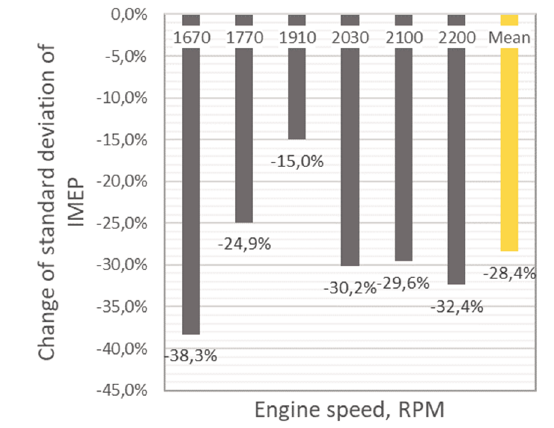
Fig. 5. Relationship between IMEP and rotational speed for constant and variable ignition advance angle